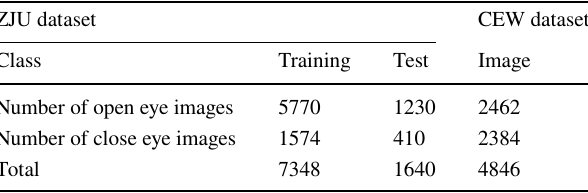
Table 2 Details of the ZJU and CEW datasets